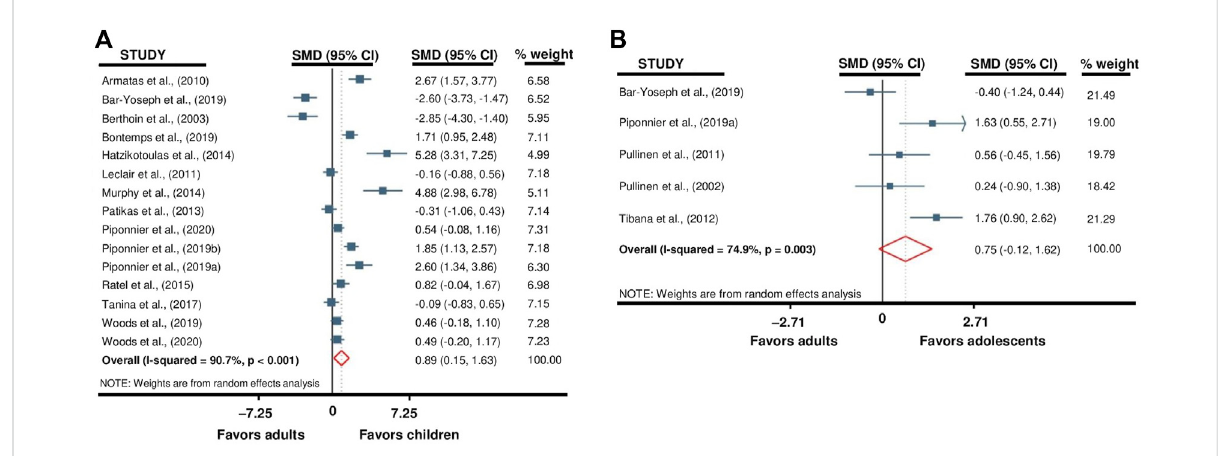
FIGURE 2 Forest plot from the meta-analysis reporting TTF differences between children versus adults (A) and adolescents versus adults (B) .